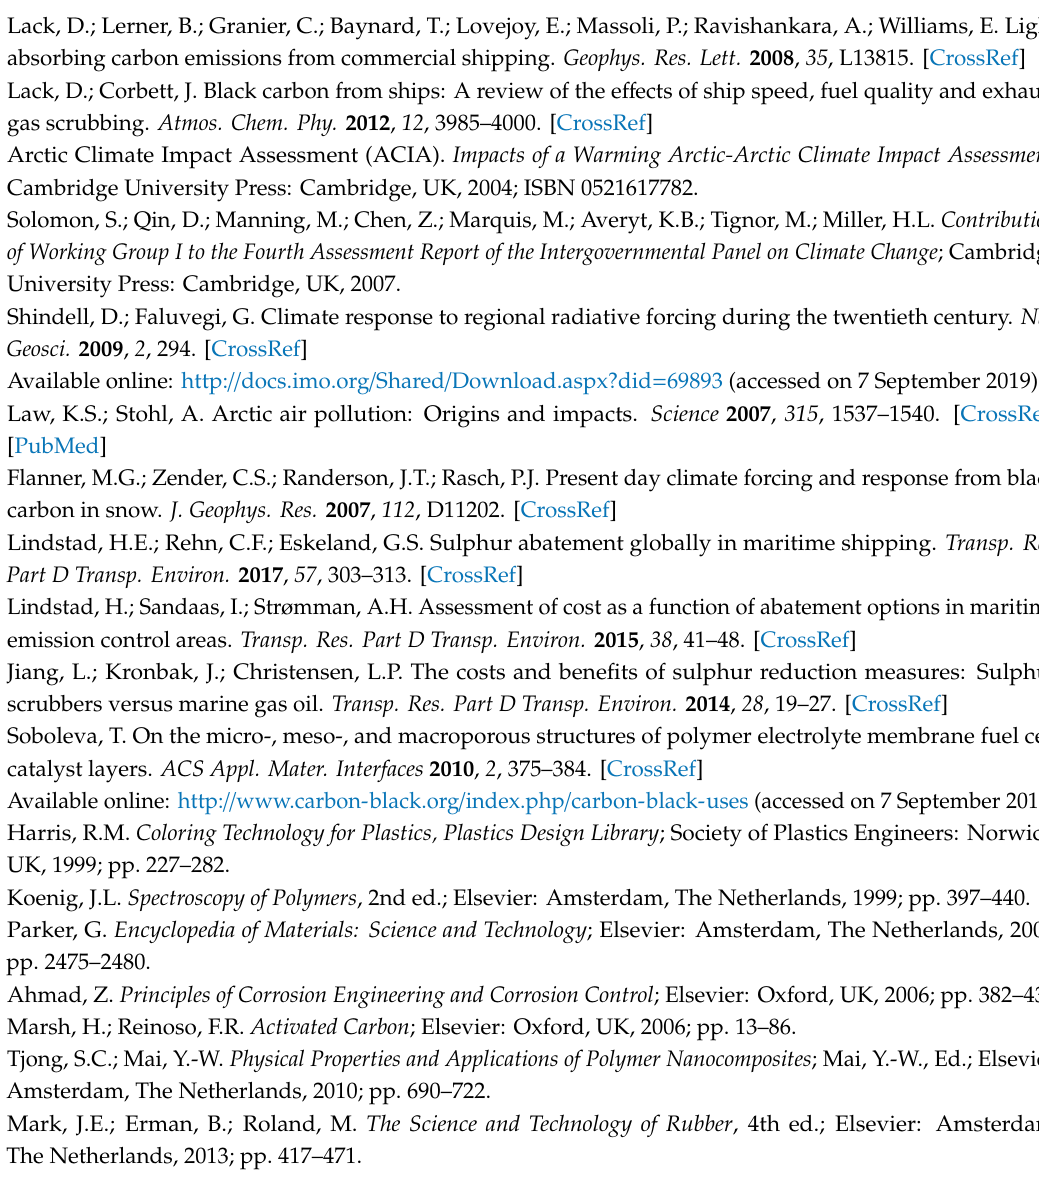
Figure S1: Transmission electron microscopy images of (a) Ketjen black and (b) Vulcan